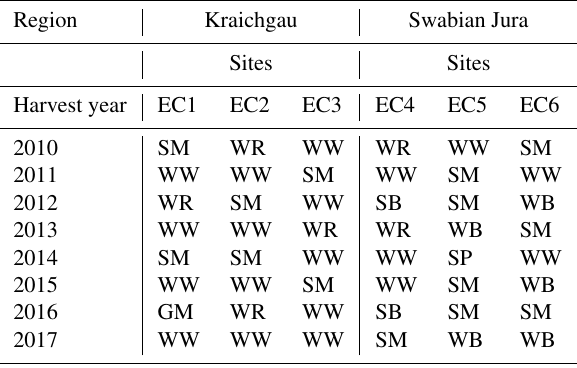
Table 2. Crop grown at the six study sites from 2010 to 2017 (har- vest